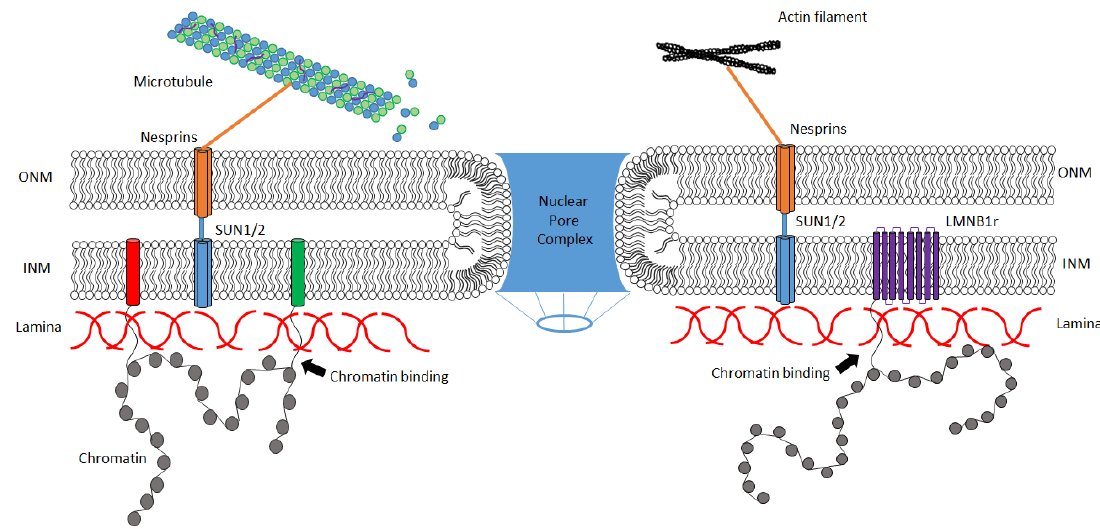
Figure 2. Schematic representation of lamina interactions. The nuclear lamina (red wavy lines) is the meshwork under the inner and outer nuclear membranes (INM and ONM, respectively). The lamina has gaps to permit the placement of nuclear pore complexes (blue). INM proteins, such as nuclear envelope transmembrane (NET) and other lamina-associated proteins (red and green cylinders) penetrate through the lamina to make contact with chromatin (gray spheres). Linker of nucleoplasm to cytoplasm complexes (LINC) formed from nesprins and SAD1/UNC-84 homology (SUN) proteins (orange and blue cylinders, respectively) make contact with actin filaments and microtubules.